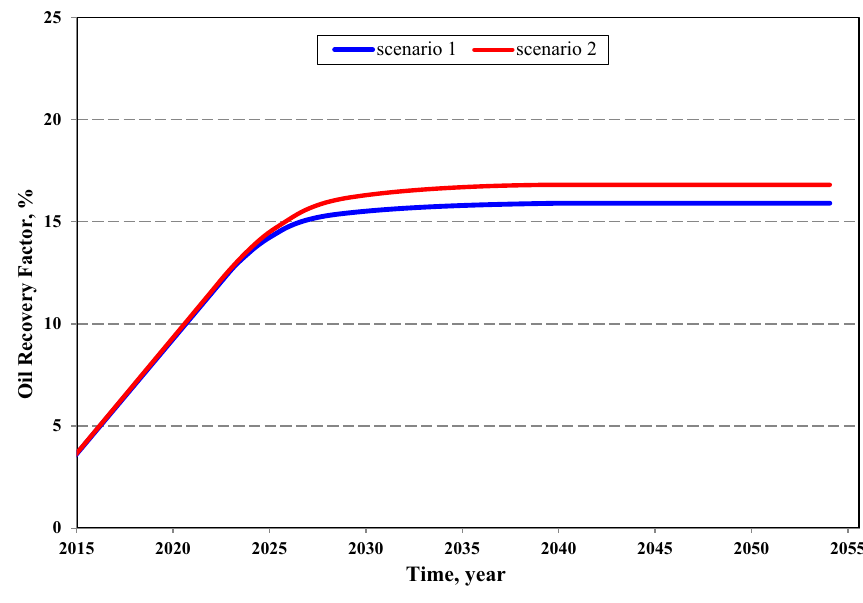
Fig. 8 Oil recovery factor under natural depletion with and with- out compositional grading